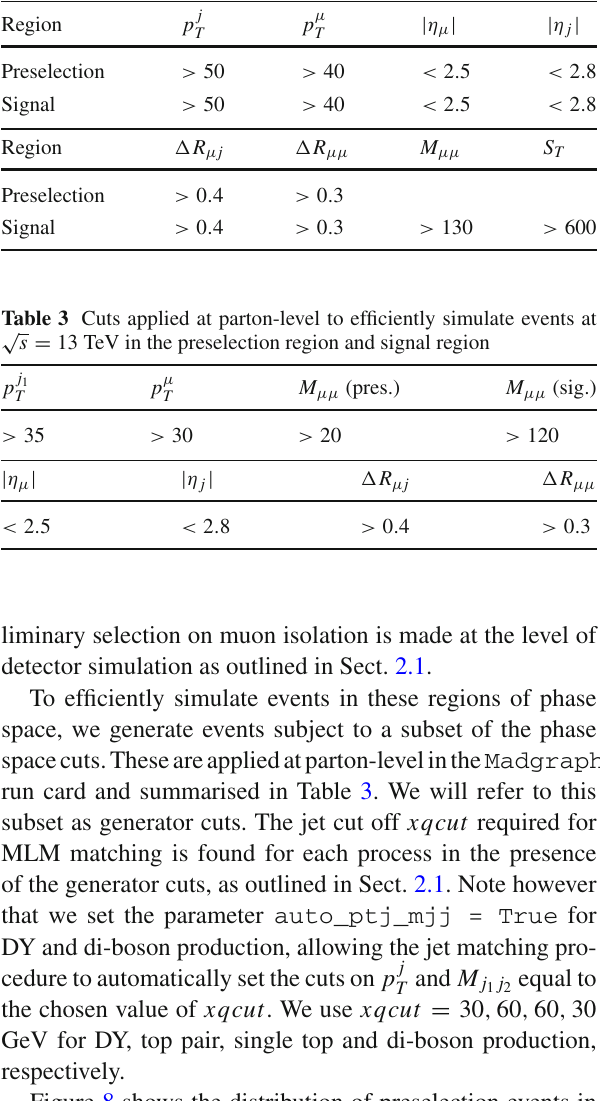
Table2 Phasespacecutsdefiningthepreselectionandsignalregionsat √ s = 13TeV.Allcutsareappliedintheanalysisafterpartonshowering and detector simulation. Cuts on p T , M μμ and S T are in units of GeV